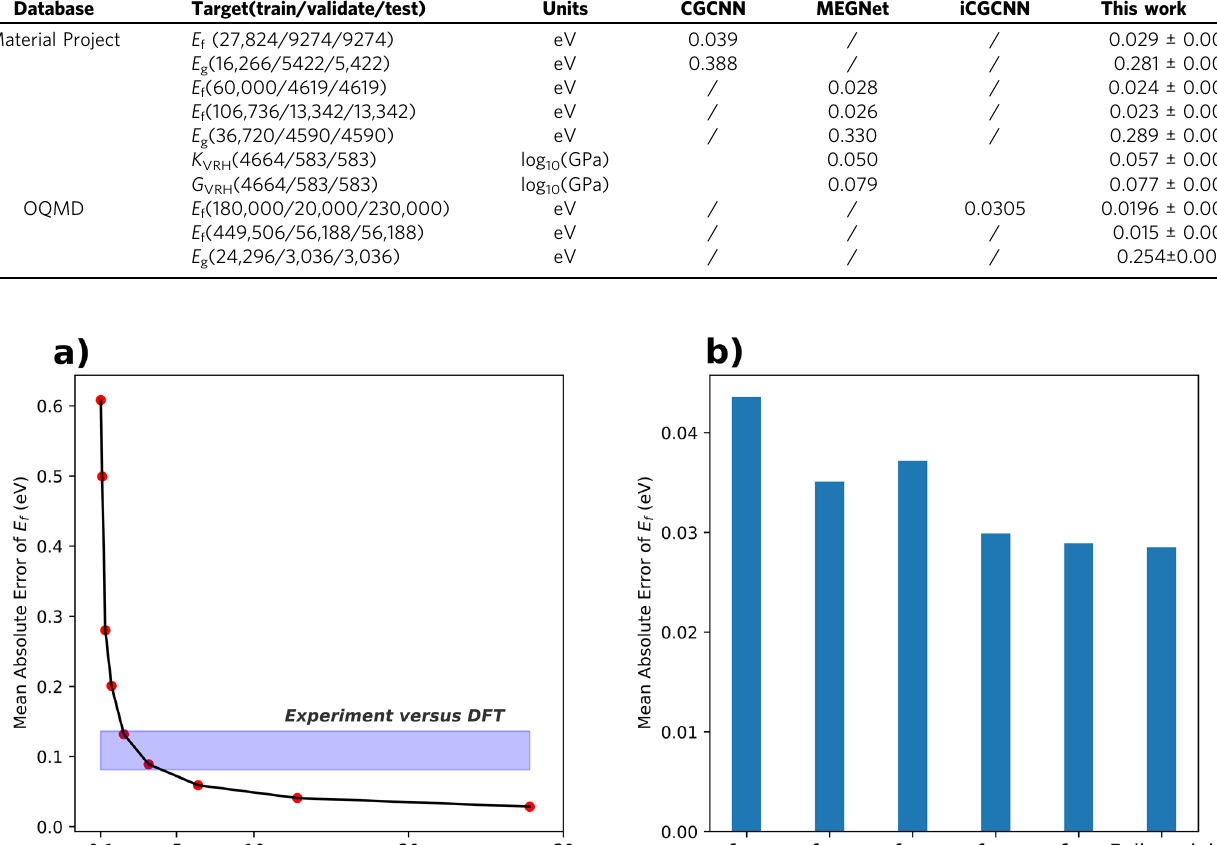
Table 1 Comparison with other approaches recently reported in the literature. Database